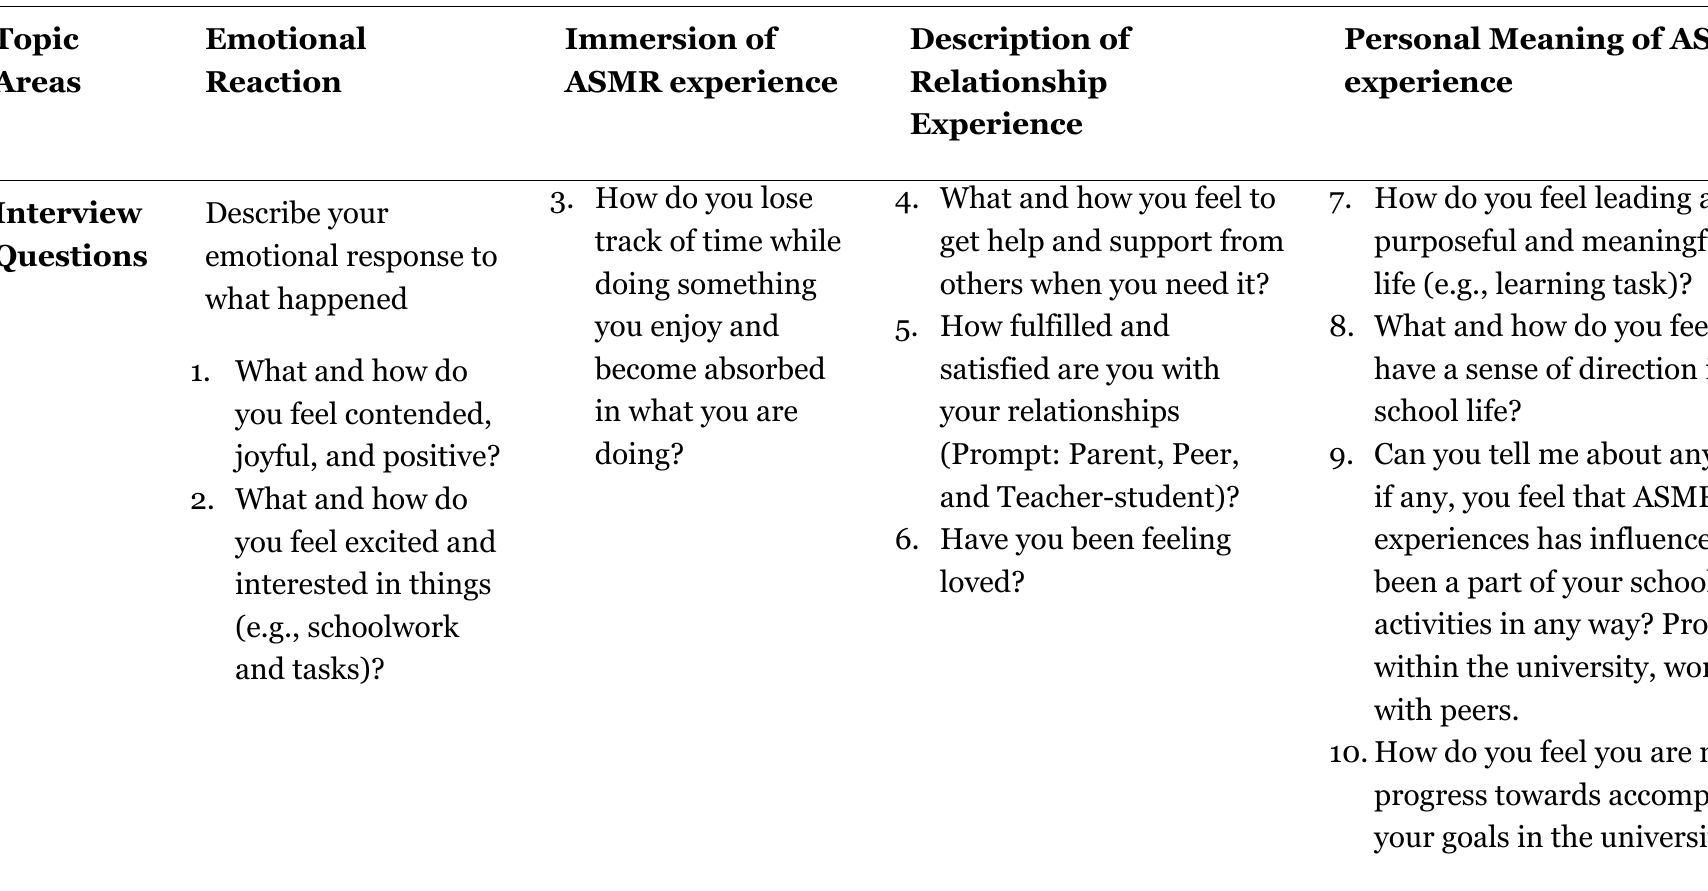
Accessible table representation of the PERMA model in figure 1 - Flow process of the emergent subthemes and subsequent application to the themes of the PERMA model, identified through IPA. Adapted and modified from Yerbury and Boyd